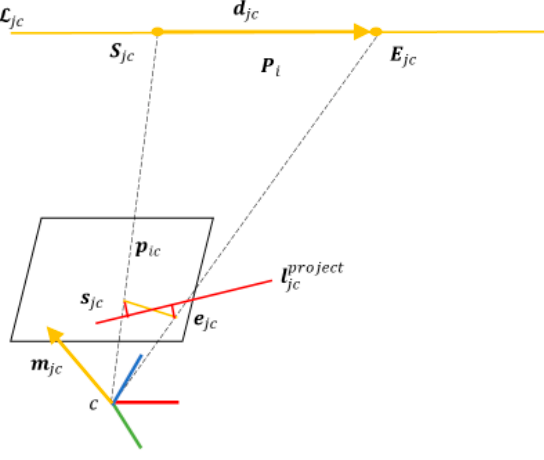
Figure 3. Plücker coordinate of a straight line.